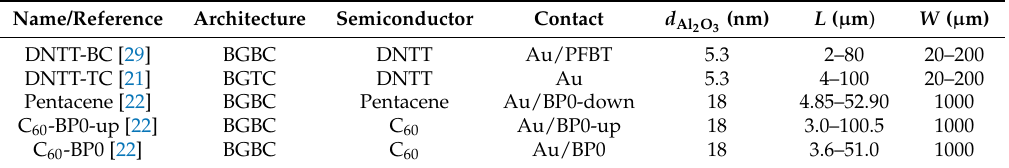
Table 1. Device architecture, materials employed for the organic semiconductor and the source and drain contacts, gate-dielectric thickness d Al , and the range of channel lengths L and channel 2 O 3 widths W of the TFTs analyzed in this work. Device architectures are the bottom-gate, bottom-contact (BGBC) and the bottom-gate, top-contact (BGTC) structure. The Au contacts of the BGBC TFTs were functionalized with either pentafluorobenzenethiol (PFBT), 2-phenylpyrimidine-5-thiol (BP0-down), 4-(2-mercaptophenyl)pyrimidine (BP0-up), or biphenyl-4-thiol (BP0). DNTT TFTs with channel lengths L ≤ 4 µ m have a channel width of 20 µ m, and DNTT TFTs with channel lengths L > 4 µ m have a channel width of 200 µ